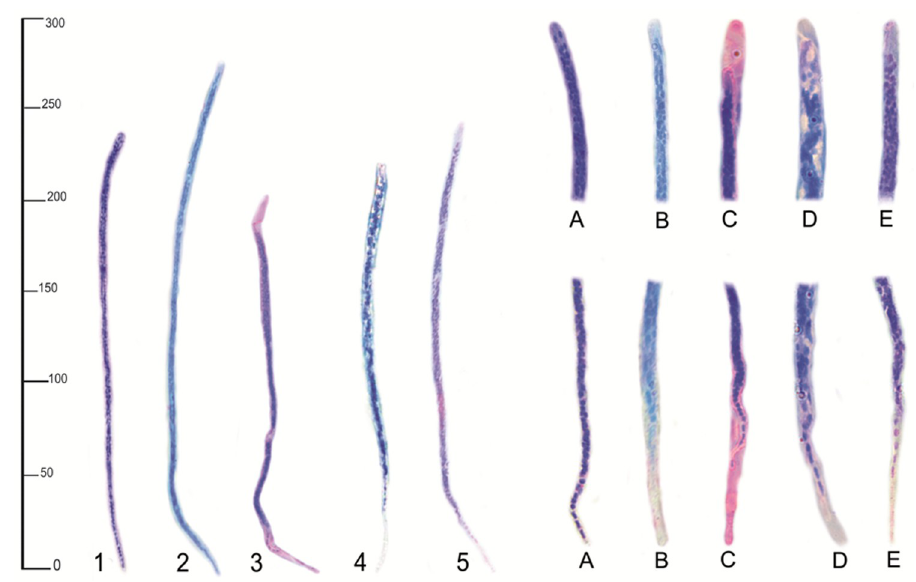
Fig 2. Morphology of the microfilariae detected in ring-tailed coatis ( Nasua nasua ) and domestic dogs from the studied area. 1. Mansonella sp. 1: A- Anterior and posterior; 2. Mansonella sp. 2: B—Anterior and posterior; 3. Onchocercidae gen. sp. 1—C: anterior and posterior; 4. Onchocercidae gen. sp. 2—D: Anterior and posterior; 5. Acanthocheilonema reconditum —E: anterior and posterior. 100x magnification light microscopy.